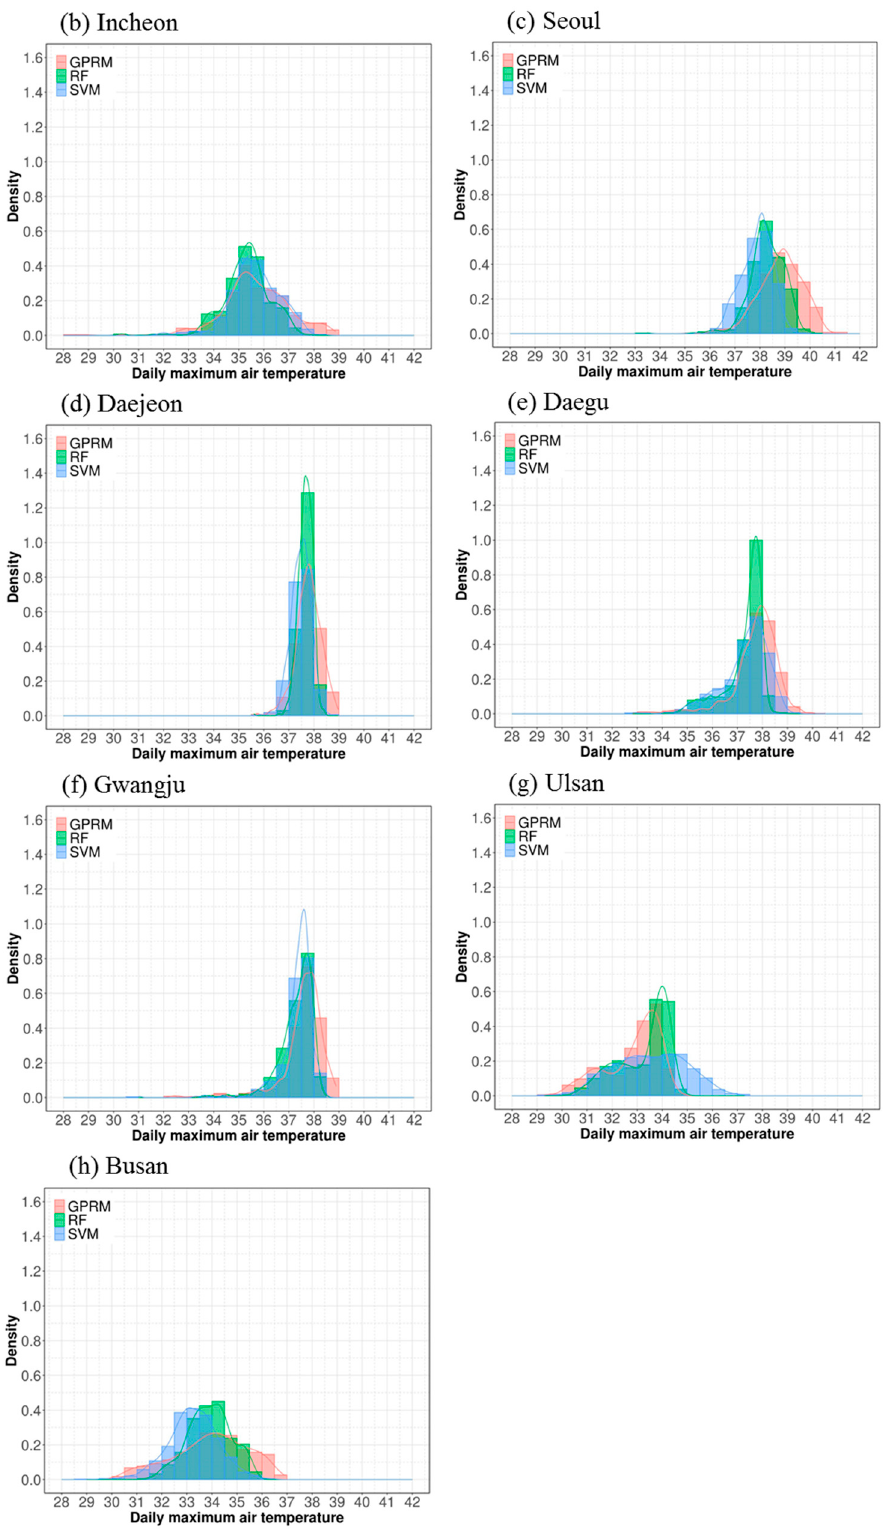
Figure 6. Comparison of daily maximum temperature distributions (on 1 August 2018) with respect to the techniques for a downscaled 1 km resolution. ( b ) Incheon; ( c ) Seoul; ( d ) Daejeon; ( e ) Daegu; ( f ) Gwangju; ( g ) Ulsan; ( h ) Busan. ( b – h ) are the analysis areas shown in Figure 1.